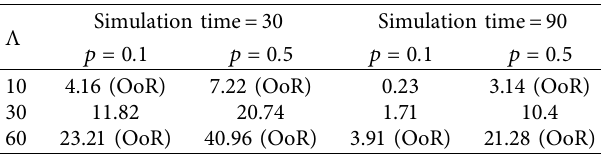
Table 10: Results for scenario 6 aimed to get minimum ϕ required to I ( t ) ⟶